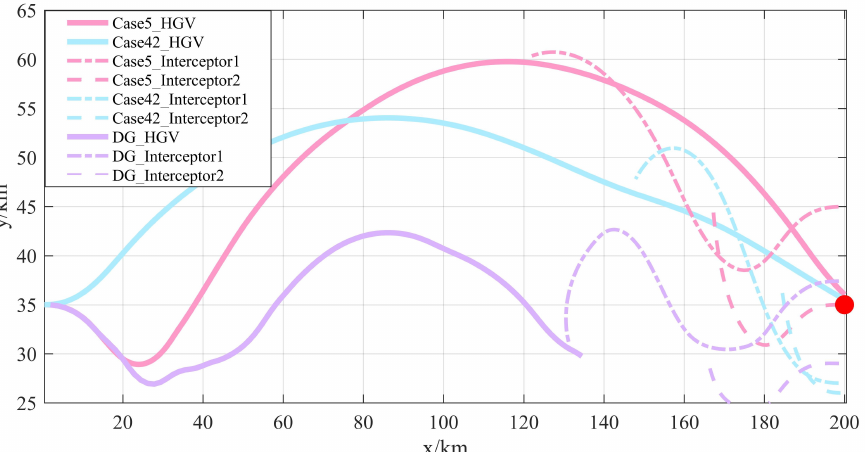
Figure 10. Vertical motion comparison between RBT-DDPG(Cases 5 and 42) and Differential Game. The DG approach uses the relative angle and velocity information as input to guide the flight, and can successfully evade the interceptor. In contrast, DG cannot account for atmospheric density and cannot optimize energy, which is a significant advantage of DRL. The AN learned by RBT-DDPG chooses to dive before leaping in Case 5, whereas, in Case 42, it takes a direct leap. Furthermore, while the peak in Case 5 is 60 km, it only reaches 54 km in Case 42 before diving. The AN can control the HGV to select the appropriate ballistic inclination for the dive after escaping the interceptor.